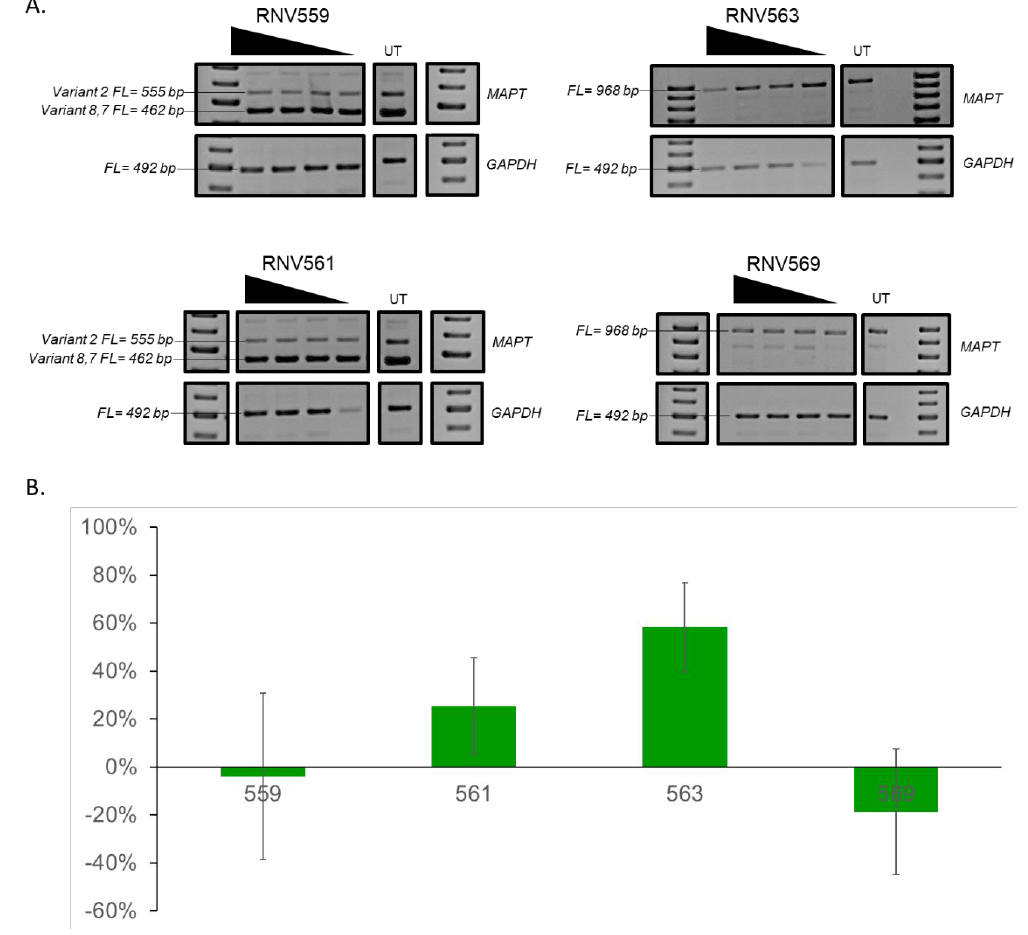
Figure 2. RT-PCR analysis of DNAzymes RNV559, RNV561, RNV563, and RNV569 treated SH-SY5Y cells. ( A ) Representative RT-PCR products of the microtubule-associated protein tau ( MAPT ) and GAPDH transcripts from SH-SY5Y cells after treatment with DNAzyme RNV559, RNV561, RNV563, and RNV569 at 400, 200, 100, and 50 nM concentrations. ( B ) The average activity of first-generation DNAzymes (at a 400 nM concentration) in SH-SY5Y cells (knockdown of the MAPT transcript). The average activity was obtained through three replicates. The error bars represent the standard error of the mean. The RNA from RNV559- and RNV561-treated samples was analysed using primer set 3 and the RNA from RNV563- and RNV569-treated samples was analysed using primer set 4. FL, full-length; UT, untreated. GAPDH was used as a loading control. The gel images were cropped to highlight the MAPT -specific products and the corresponding house-keeping gene control GAPDH .